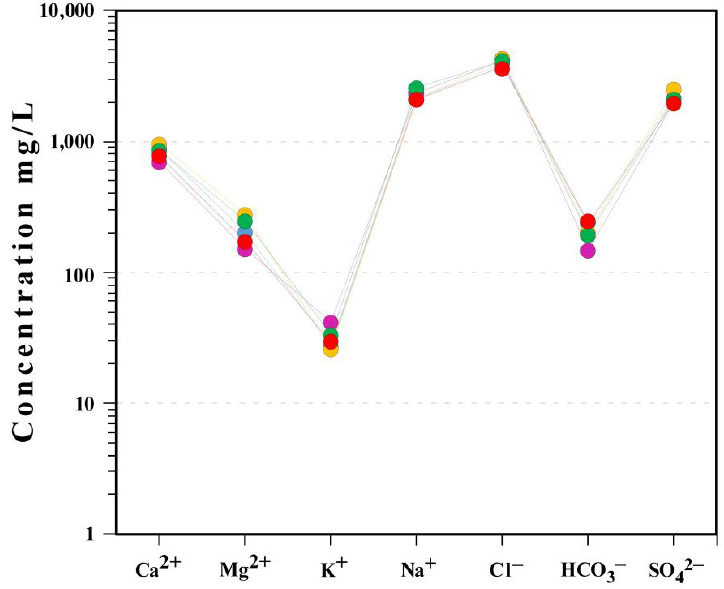
Figure 5. Schöeller – Berkaloff diagram applied to the thermal waters of Goutitir, reported for a